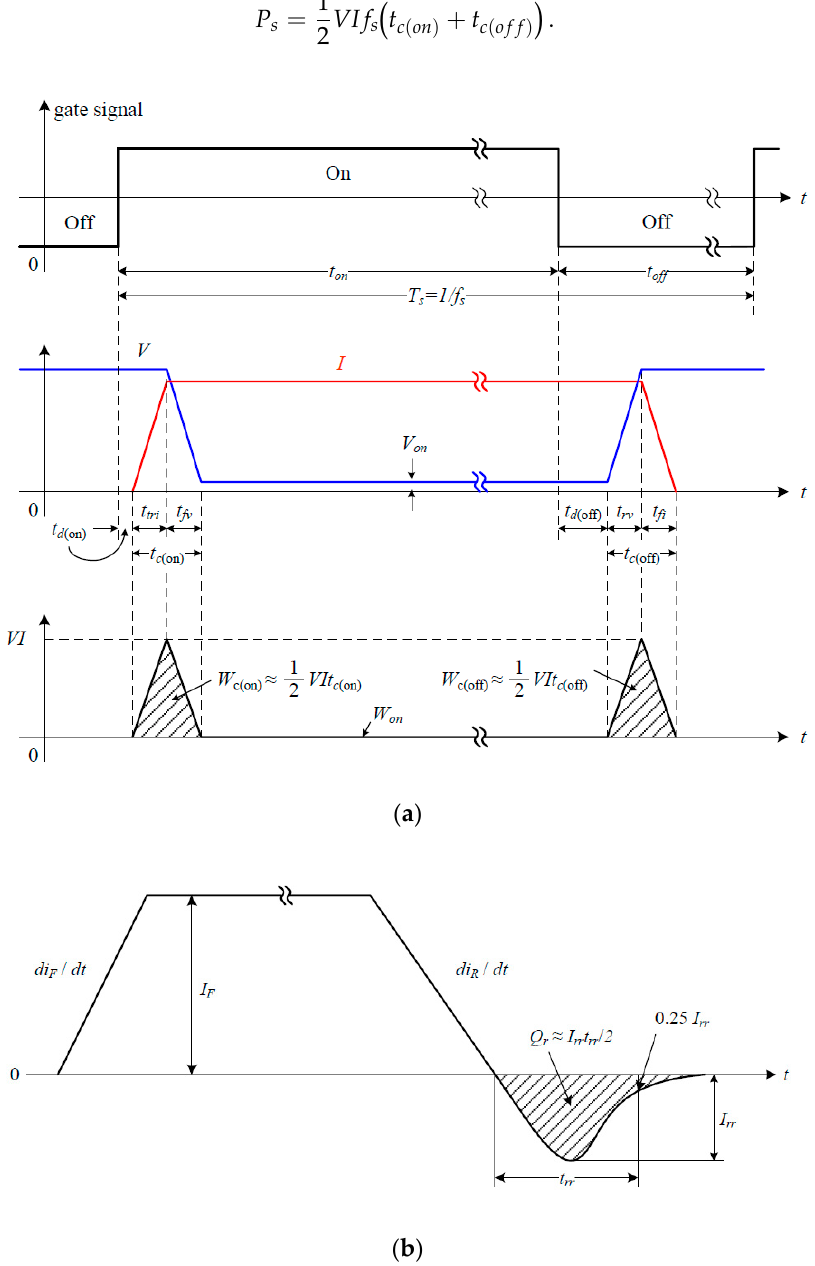
Figure 16. Switching characteristics: ( a ) switching waveforms and instantaneous switching-power loss; ( b ) current waveform for a power diode .